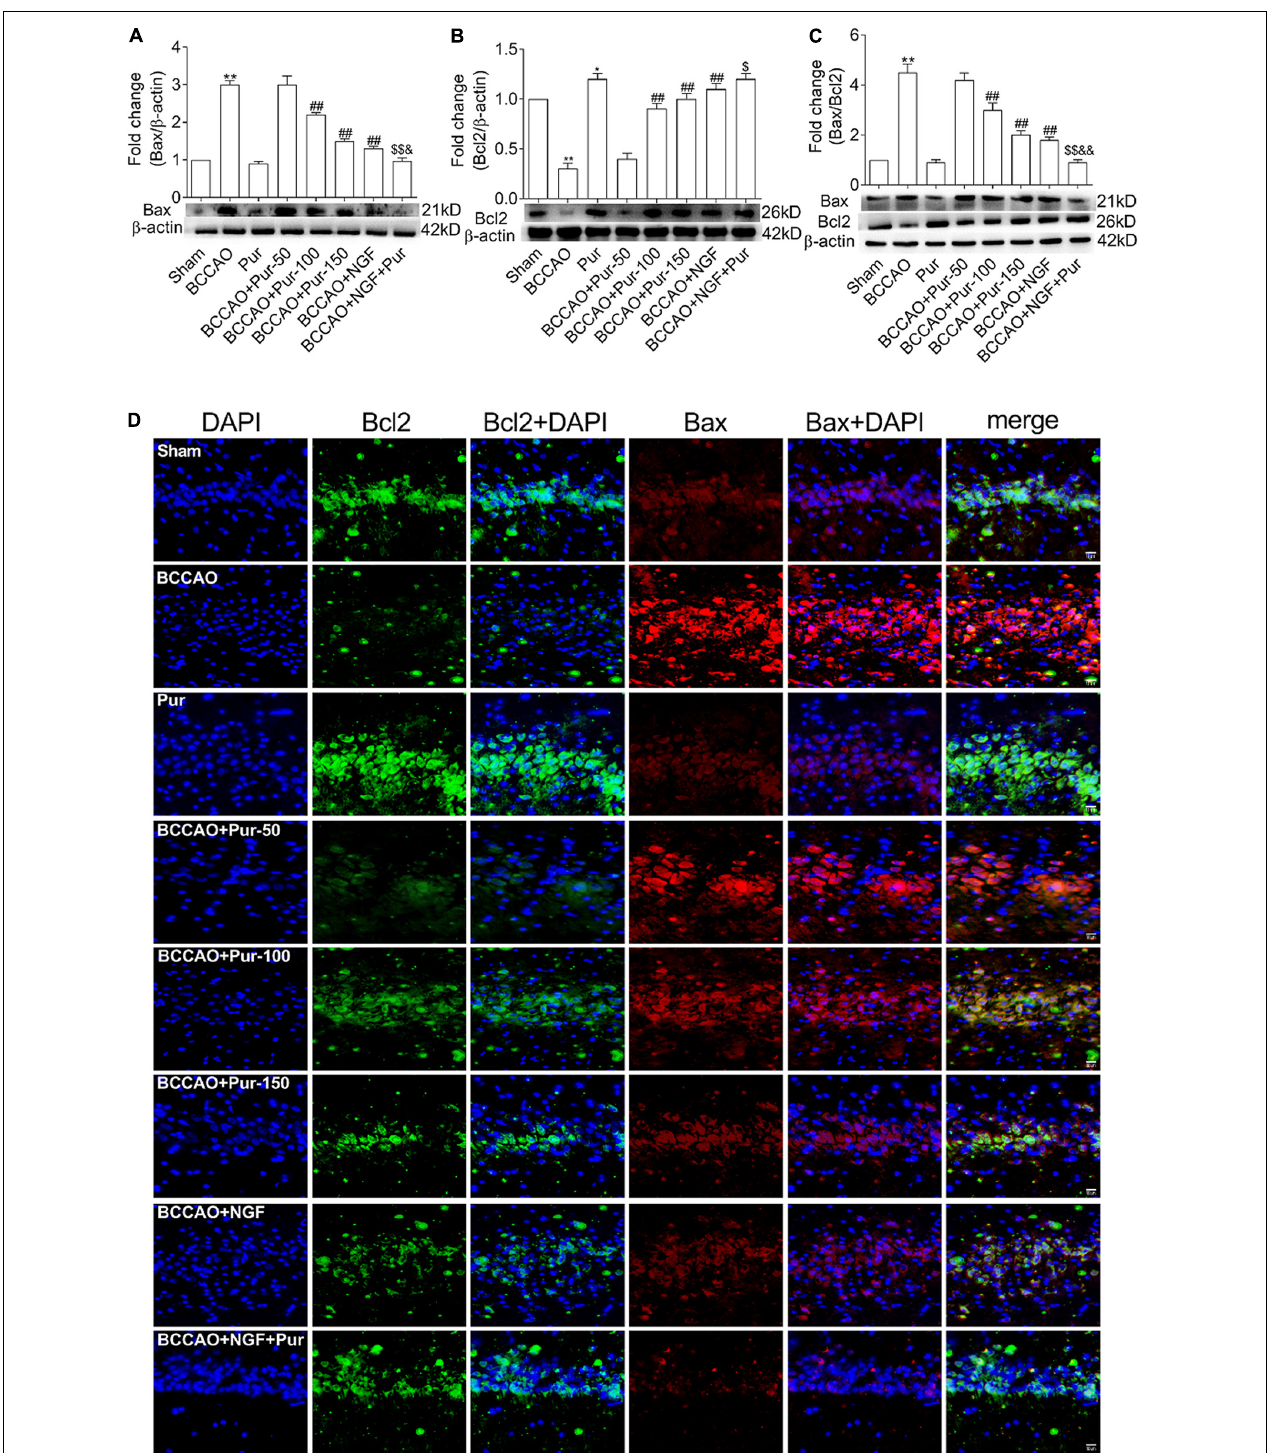
FIGURE 5 | Expression and co-localization of Bax and Bcl2 in the rat dorsal CA1 region of hippocampus. (A) Protein expression of Bax in the hippocampal dorsal CA1 region of rats. (B) Protein expression of Bcl2 in the hippocampal dorsal CA1 region of rats. (C) Bax/Bcl2 ratios in the hippocampal dorsal CA1 region of rats. (D) Pur’s effects on Bax and Bcl2 co-localization in the hippocampal dorsal CA1 region of rats, assessed by immunofluorescent double staining. Representative micrographs are shown at × 200. Results were mean ± SEM ( n = 6). * P < 0.05, ** P < 0.01 vs. Sham; ## P < 0.01 vs. BCCAO; $ P < 0.05, $$ P < 0.01 vs. BCCAO + Pur (150 mg/kg/day); & P < 0.05, && P < 0.01 vs. BCCAO + NGF (20 mg/kg/day).